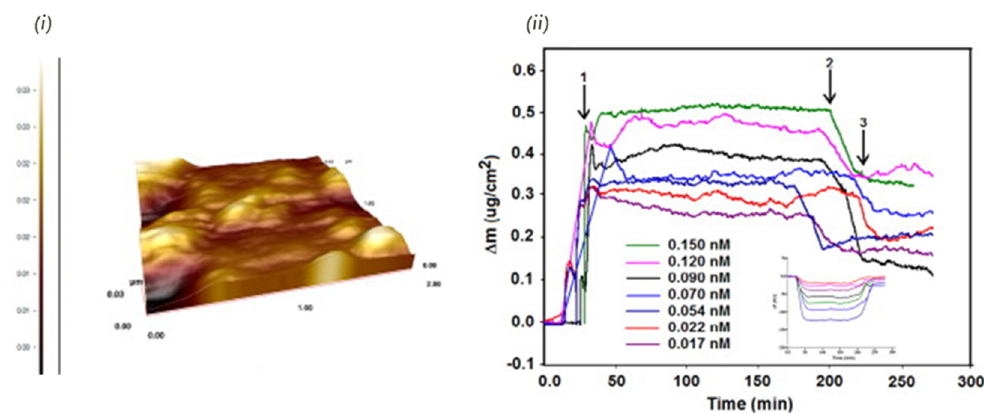
Figure 9. QCM detection of tobramycin using a molecularly imprinted polymer: ( i ) AFM image of MIP film. ( ii ) The effect of concentration on QCM response of target: (1) adsorption; (2) desorption; and (3) regeneration. Reprinted from [222]. Copyright (2014), with permission from Elsevier. Table 8. Imprinted polymer-piezoelectric sensors for food safety.